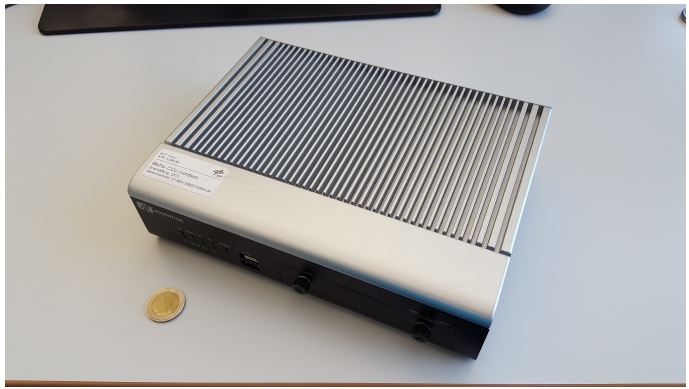
Figure 1: V2X communication